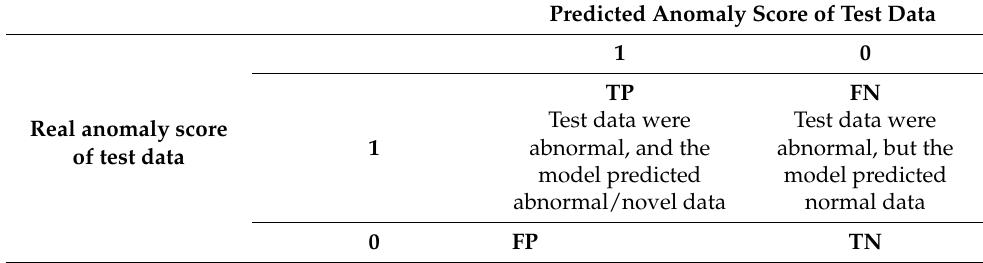
Table 2. Confusion matrix during evaluation.